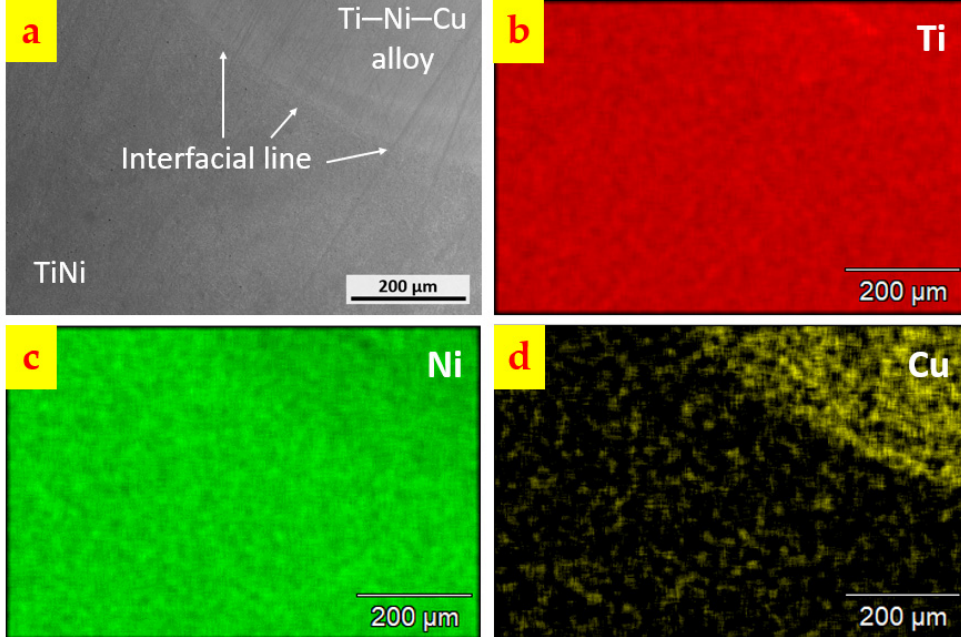
Figure 4. ( a ) Interface between the DED Ti–Ni–Cu alloy and the TiNi substrate. ( b ) Element mapping of Ti. ( c ) Element mapping of Ni. ( d ) Element mapping of Cu. Notice that the intensity of the Cu signal from the Ti–Ni–Cu alloy above the interfacial line is much stronger than the area within the TiNi substrate below the interfacial line.